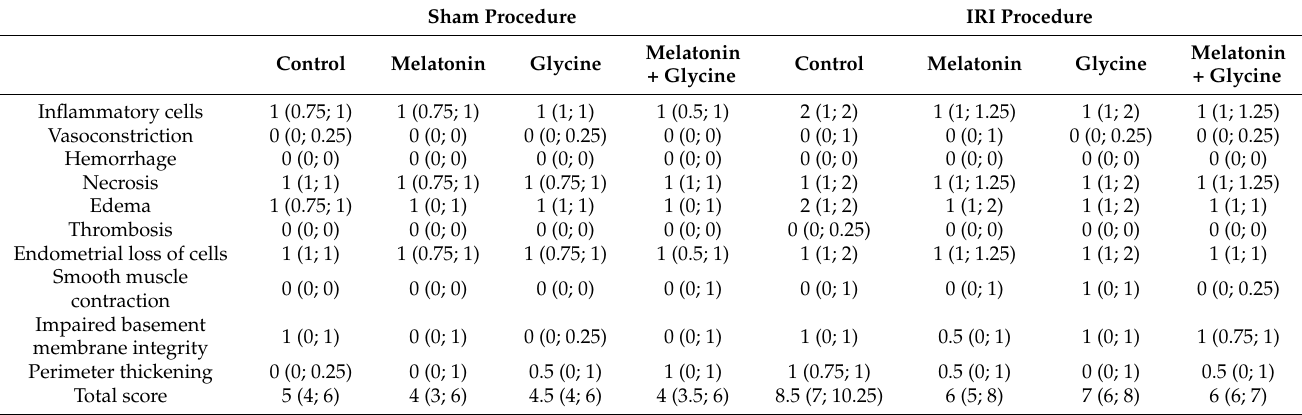
Table 1. Results of the scoring system for uterus IRI